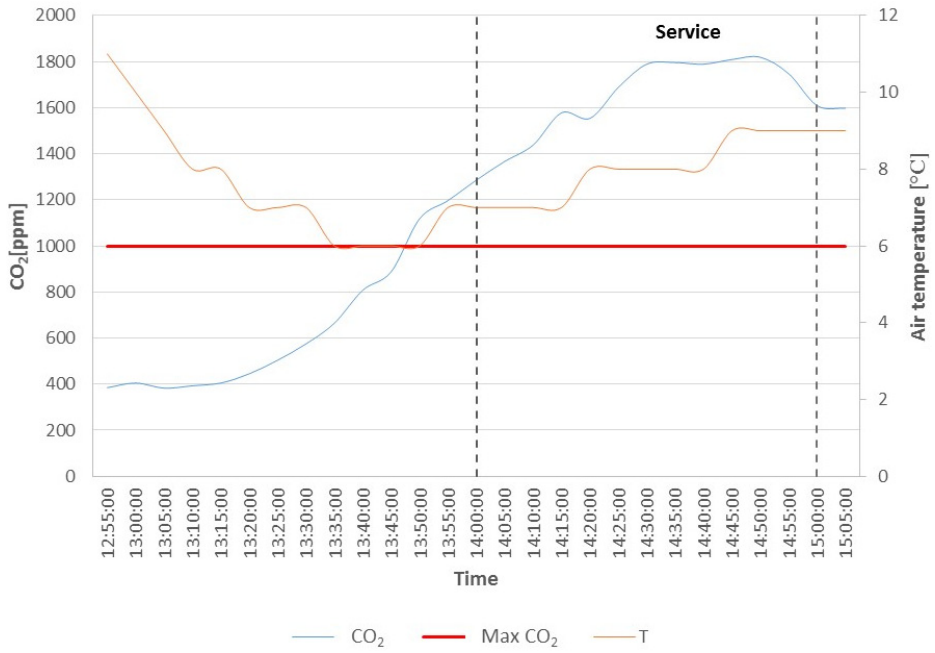
Figure 9. CO 2 concentration during the service in winter time.